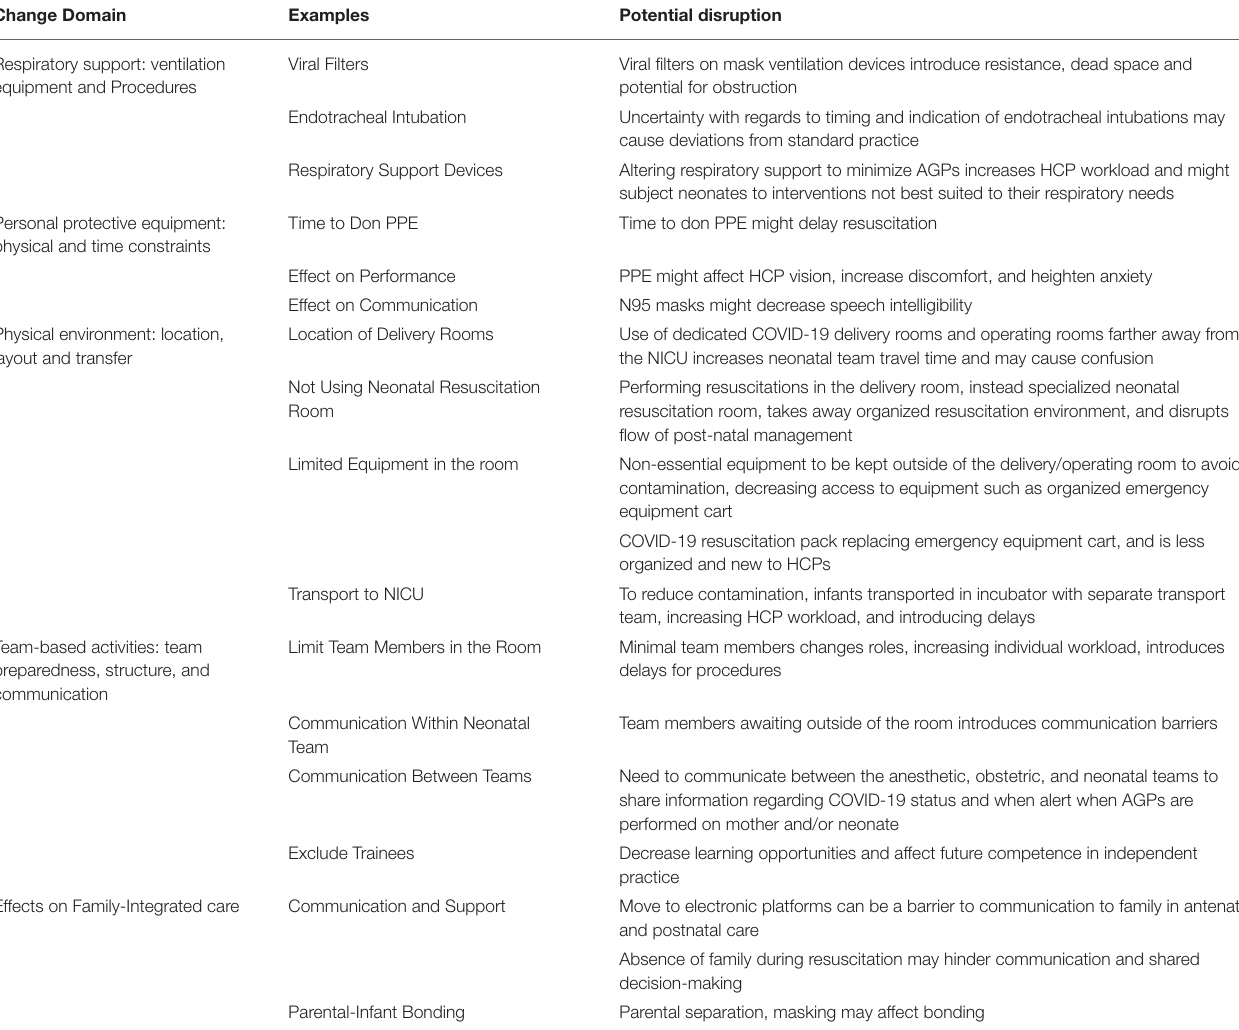
TABLE 1 | Examples of changes in routine neonatal resuscitation practices that may disrupt care. Change